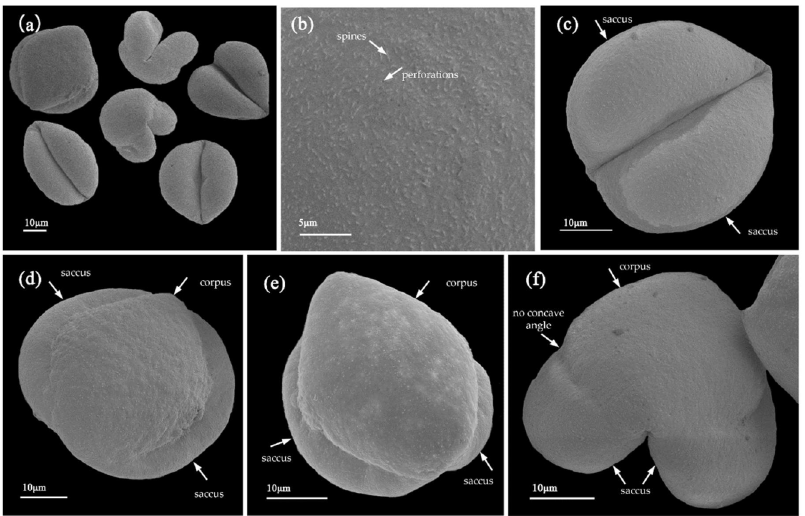
Figure 1. C. argyrophylla pollen grains. ( a ) Pollen grains of C. argyrophylla in the polar and equatorial view. ( b ) Mixture of granulate and striate ornamentation and perforation on the pollen exine surface. ( c ) Two sacci in the polar distal view. ( d , e ) Polar proximal view. ( f ) Two sacci in the equatorial view, no concave